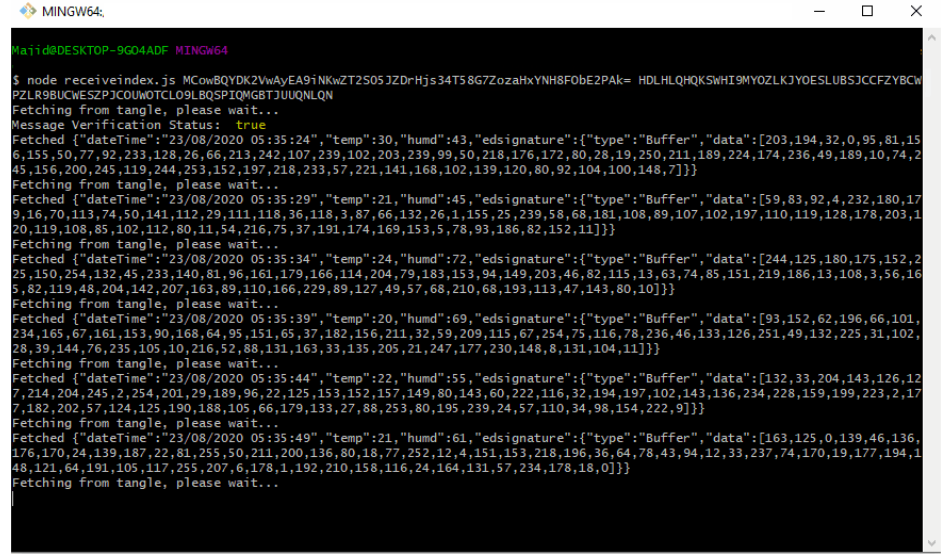
Figure 13. Fetching the rest of the message payload using a ‘public key’ and ‘root’ in ‘public’ mode.